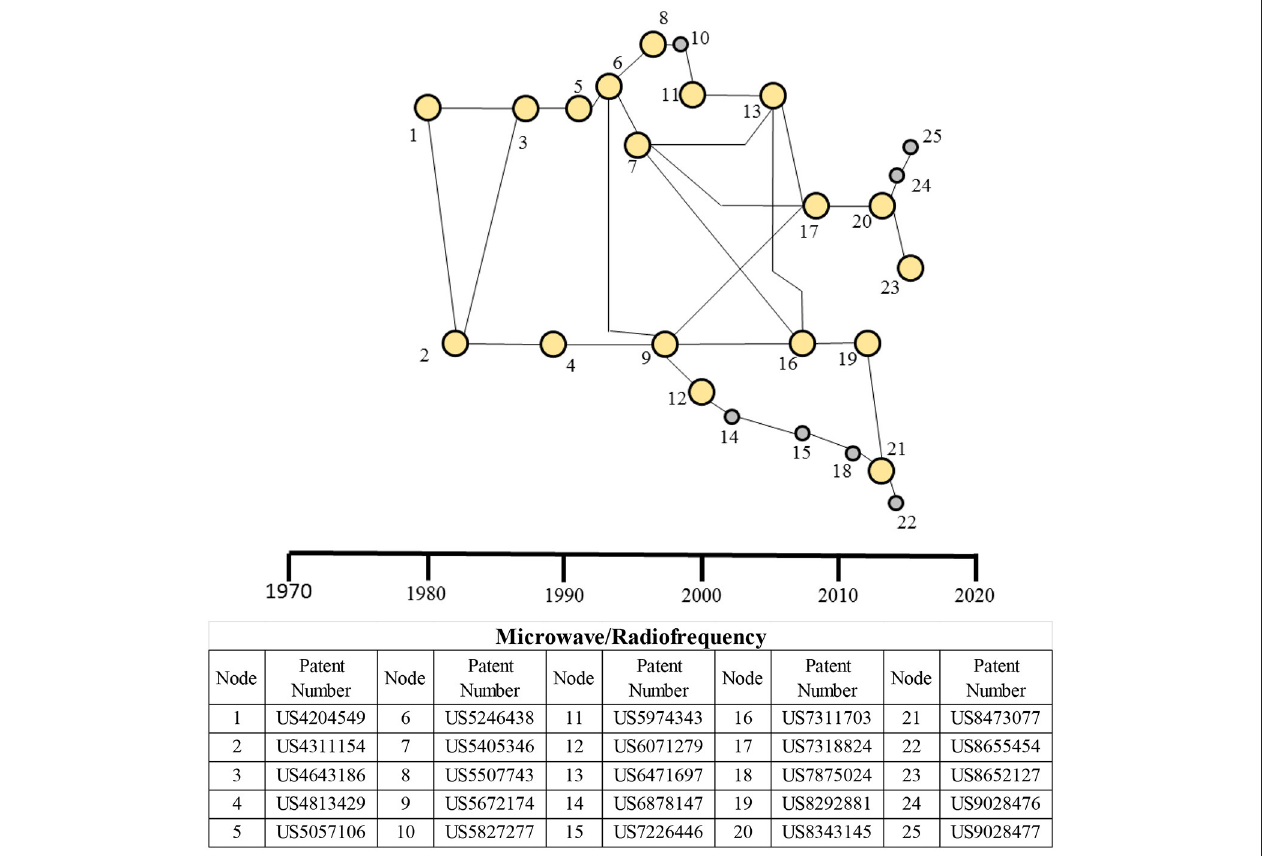
FIGURE 8 | Main paths for the microwave/RF-based therapeutic domain. The table presents details of each patent in the main paths. High-persistence patents are shown as bigger yellow circles, whereas the low-persistence patents are shown as smaller gray